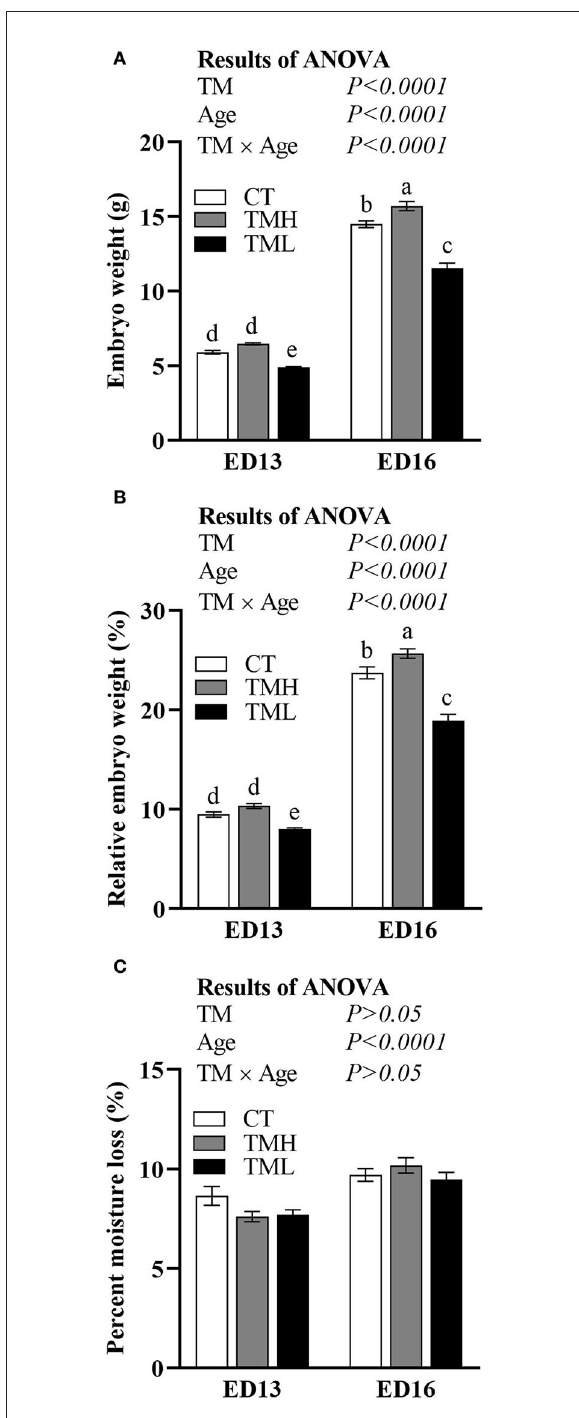
FIGURE2 The changes in embryonic weight (A) , relative embryonic weight (B) , and percent moisture loss (C) exposed to control temperature (CT, 37.6 ◦ C) and TM with high temperature (TMH, 39 ◦ C, 8 h/day) or low temperature (TML, 20 ◦ C, 1 h/day) from embryonic day (ED) 8 to ED 15. The number of chicks in each group was n = 12–15. Values are mean ± SEM. Different superscripts indicate significant ( P < 0.05) differences. TM, thermal